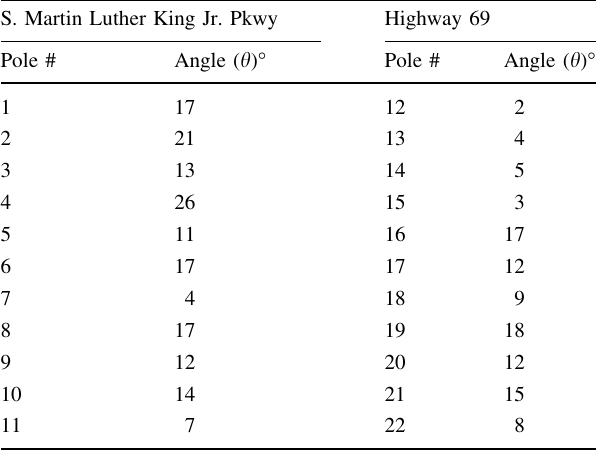
Table 2 Sample data of existing pole conditions in Beaumont, Texas before exposure to further wind stress. Source Adapted from Eren Tokgoz et al.